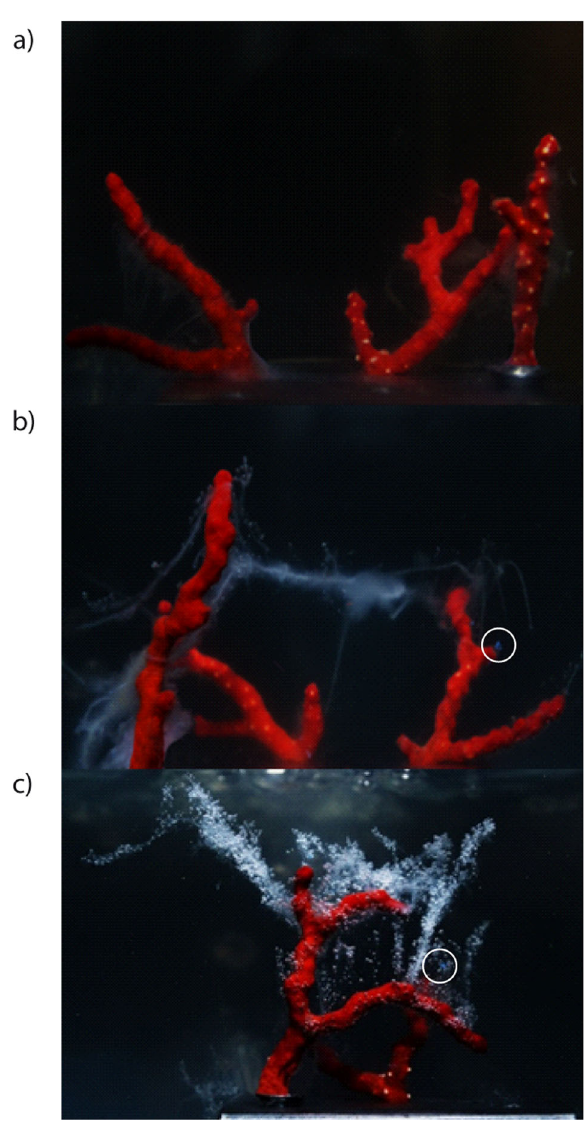
Fig. 3 The red coral ( Corallium rubrum ) in the experimental systems exposed to varying concentrations of microplastic particles after 10 days of experiment. a Low, b medium, and c high concentrations of microplastic particles. Mucus release increases with increasing microplastic particles concentration. White circles indicate microplastics items trapped by mucus (polyethylene